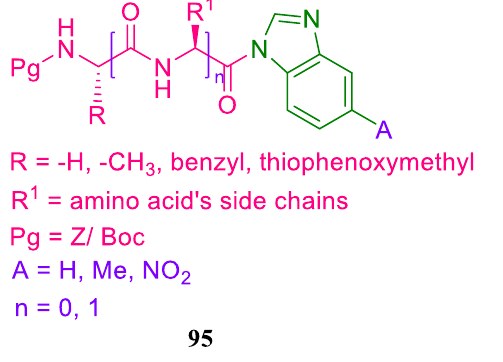
Figure 77. Amino acid/Peptides conjugated to benzimidazole derivatives.